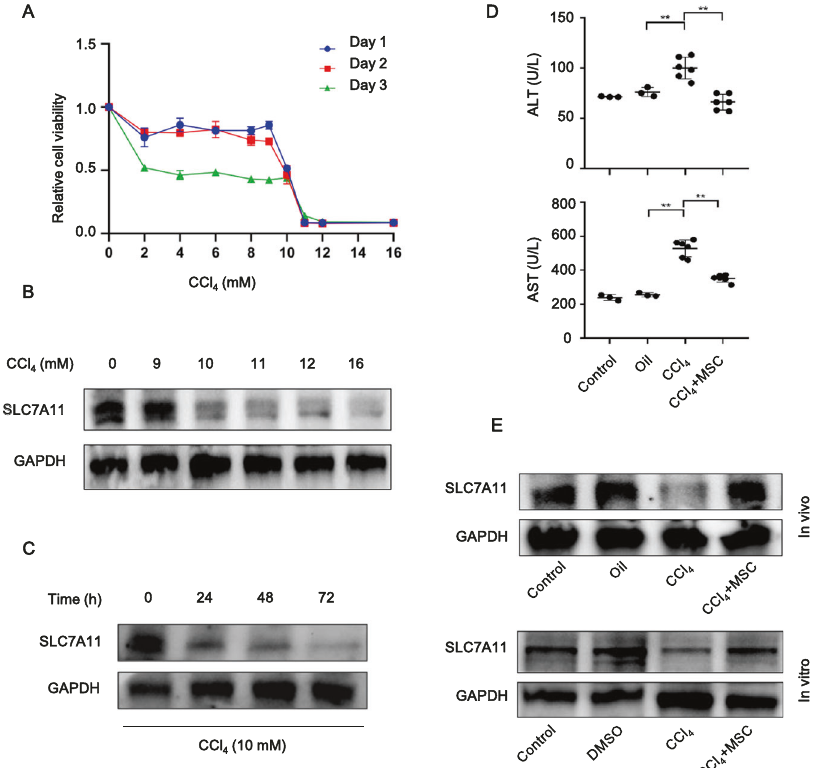
Fig. 3 SLC7A11 protein level was downregulated in CCl 4 -induced ALI and upregulated following MSC treatment in vivo and in vitro. A Cell viability was measured on days 1, 2, and 3, after hepatocytes were treated with 0, 2, 4, 6, 8, 9, 10, 11, 12, and 16 mM CCl 4 . B WB analysis was performed to measure the SLC7A11 protein level in mouse primary hepatocytes treated with 0, 9, 10, 11, 12, and 16 mM CCl 4 for 48 h. C or with 10 mM CCl 4 for 0, 24, 48, and 72 h. D Coculture of primary hepatocytes with MSCs signi fi cantly reduced AST and ALT induced by CCl 4 . E MSC treatment signi fi cantly reduced the downregulated SLC7A11 protein level induced by CCl 4 in vivo and in vitro. Signi fi cance was calculated by one-way ANOVA with Tukey ’ s post hoc test. * p < 0.05 or ** p < 0.001 indicated a signi fi cant difference between